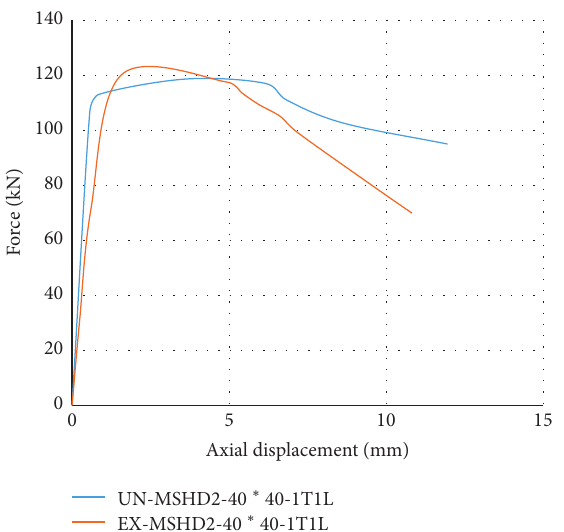
Figure 11: Force-displacement diagram of model and laboratory sample.